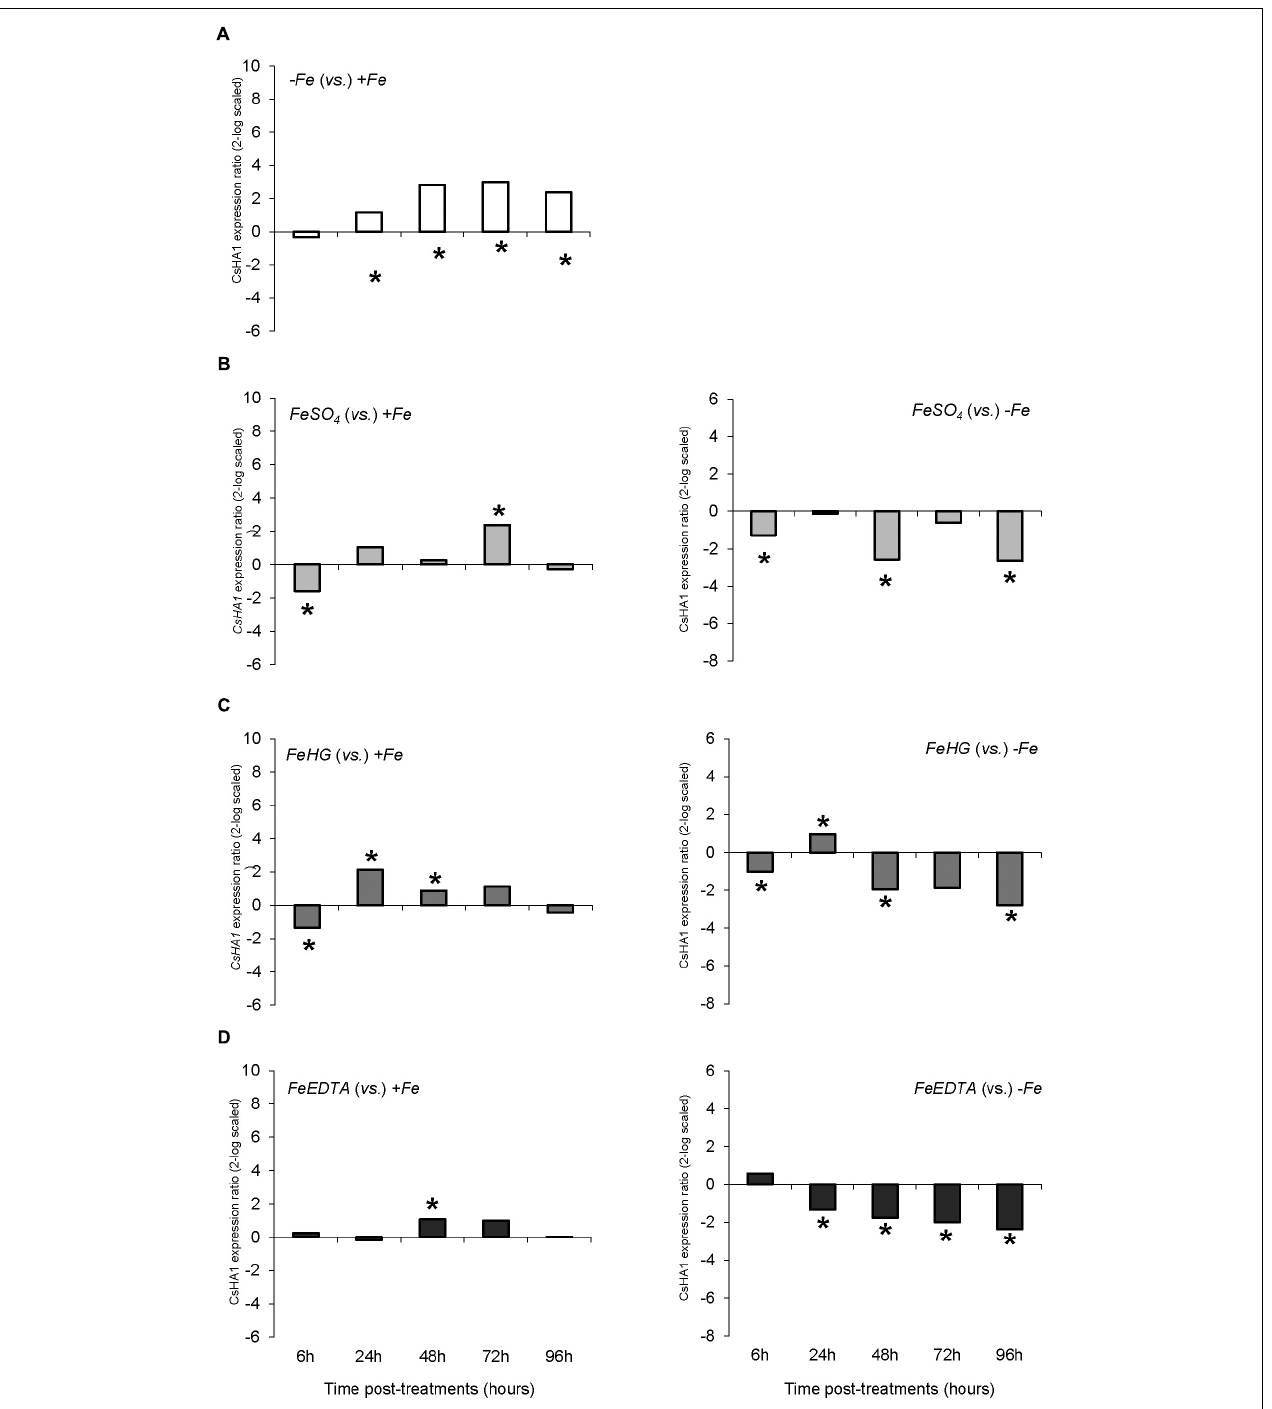
FIGURE 8 | CsHA1 expression results in cucumber roots from Experiment II. Plants were grown in a nutrient solution with 5 µ M Fe, and then some of them were transferred to nutrient solutions with 40 µ M Fe (+ Fe ). The rest were transferred to nutrient solutions without Fe (– Fe ). A fourth of the – Fe plants received no further treatments in order to function as a deficient control. The rest of the plants received a total amount of 2.54 mg Fe/plant (divided into a 3-day application) of one of the following treatments: FeSO 4 , 3 mM FeSO 4 ; Fe-HG , 3 mM Fe(III)-heptagluconate; Fe-EDTA , 3 mM Fe(III)-EDTA. (A) Expression of CsHA1 in root of – Fe plants versus + Fe plants. (B) Expression of CsHA1 in root of FeSO 4 plants versus + Fe (left) and – Fe (right) plants. (C) Expression of CsHA1 in root of Fe-HG plants versus + Fe (left) and – Fe (right) plants. (D) Expression of CsHA1 in root of Fe-EDTA plants versus + Fe (left) and – Fe (right) plants. Data are means ± SE ( n = 5). Asterisks indicate significant differences between treatments at P < 0.05 based on one-way ANOVA and Fisher’s post hoc test. Statistical analysis of relative gene expression results was assessed using P-pairwise fixed reallocation randomization